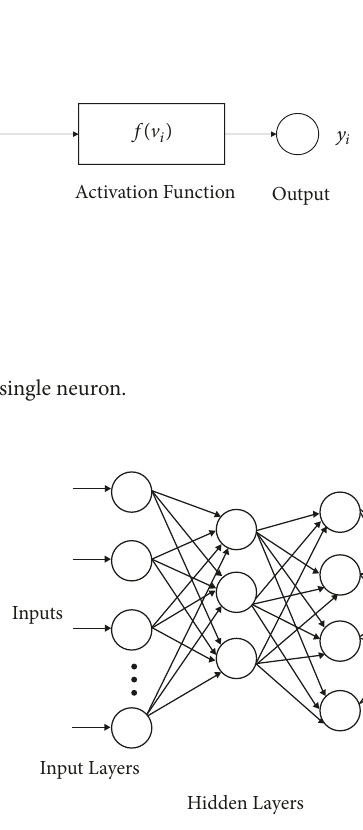
Figure 2: A model of multilayer neural